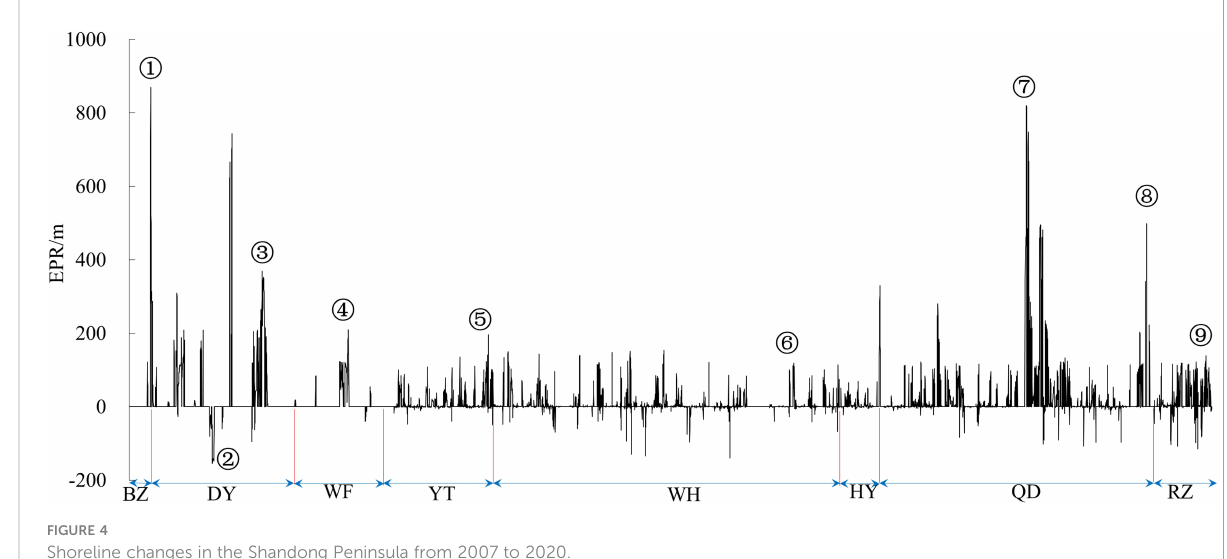
FIGURE 4 Shoreline changes in the Shandong Peninsula from 2007 to 2020.